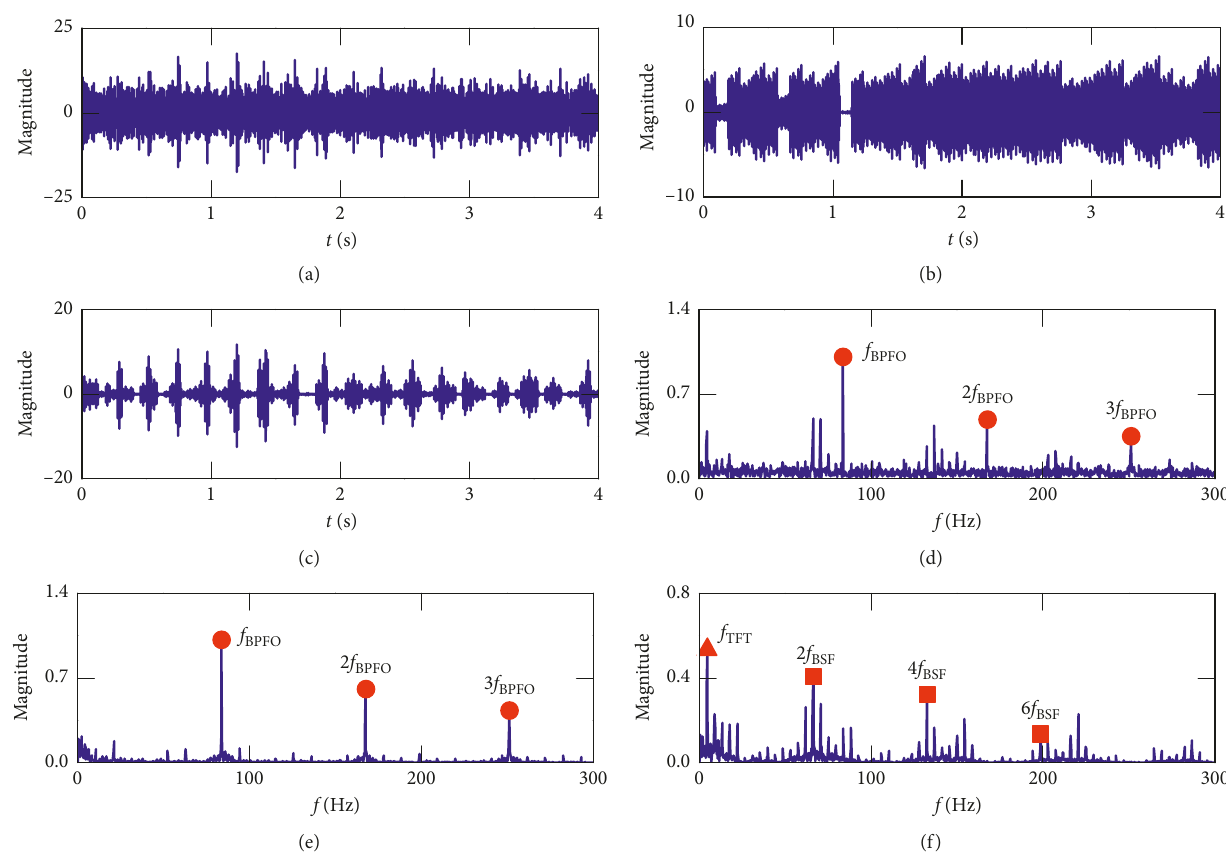
Figure 20: Results obtained by the proposed CPS for a bearing compound fault signal: (a) IMF 2; (b) first periodic impact component extracted from (a); (c) second periodic impact components extracted from (a); (d, f) squared envelope spectra of (a–c), respectively.